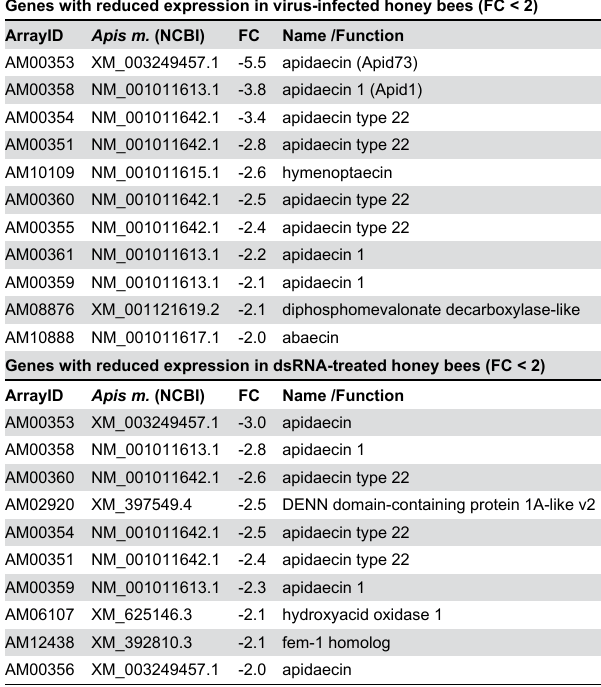
Table 1. Identification of the honey bee transcripts with the greatest decrease in expression in response to virus infection or dsRNA-treatment.